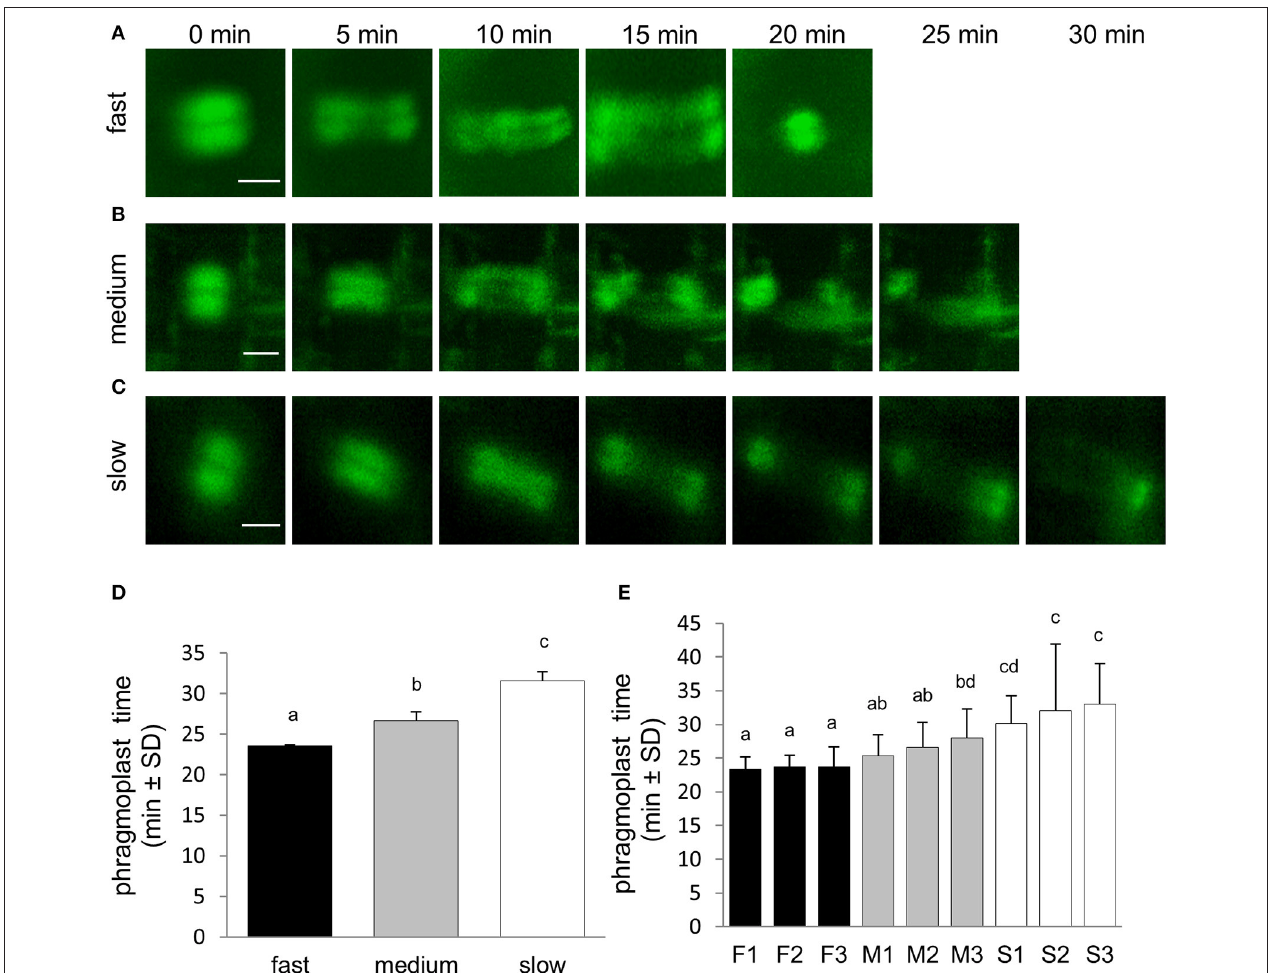
FIGURE 5 | Duration of the phragmoplast stage of the cell division. (A–C) Series of stills from time-lapse light-sheet imaging of dividing cells in root epidermis and cortex of M. sativa plants expressing 35S::GFP:MBD construct. Sequence of phragmoplast stages is shown for fast-growing roots (A) , medium-growing roots (B) and slow-growing roots (C) . Series of images were recorded in 5min intervals from the stage of early phragmoplast formation (time 0min). (D) Average duration time of phragmoplast stage of cell division in all roots of fast-growing, medium-growing, and slow-growing group of roots. (E) Average duration time of phragmoplast stage in all dividing cells of individual roots. Roots are arranged from shortest to longest average duration time of phragmoplast. Black bars represent fast-growing roots (F1, F2, F3), gray bars represent medium-growing roots (M1, M2, M3) and white bars represent slow-growing roots (S1, S2, S3). Different letters above the bars represent statistical significance according to one-way ANOVA test at P < 0.05. Bars = 5 µ m (A–C)